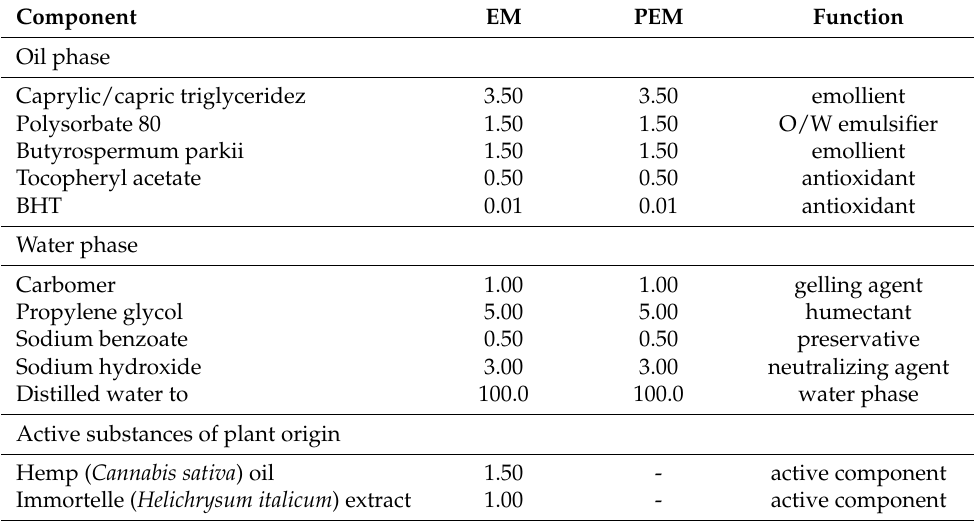
Table 2. Qualitative and quantitative compositions (%, ( w/w )) of emulgel samples: active emulgel (EM) and placebo emulgel